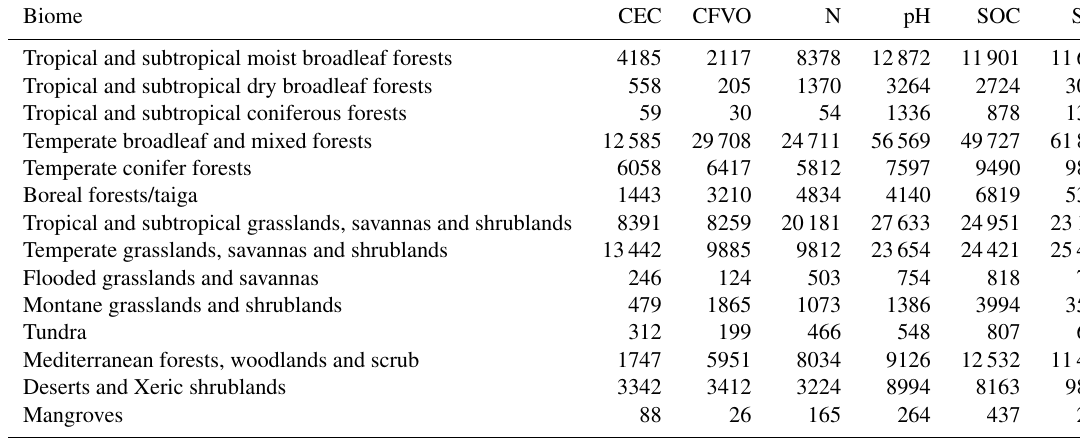
Table B1. Number of observations per property for each bioclimatic region. See Table 1 for abbreviations.